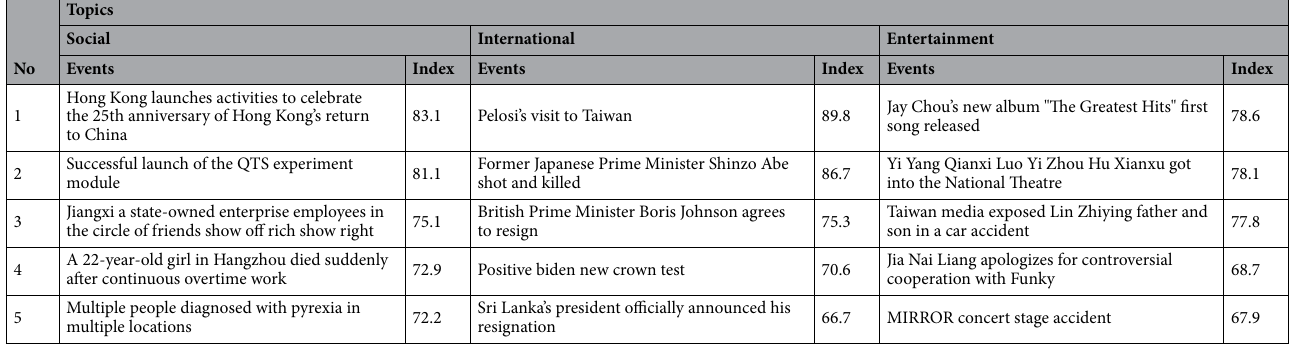
Table 1. Top 5 of events in the Zhiweidata platform under three